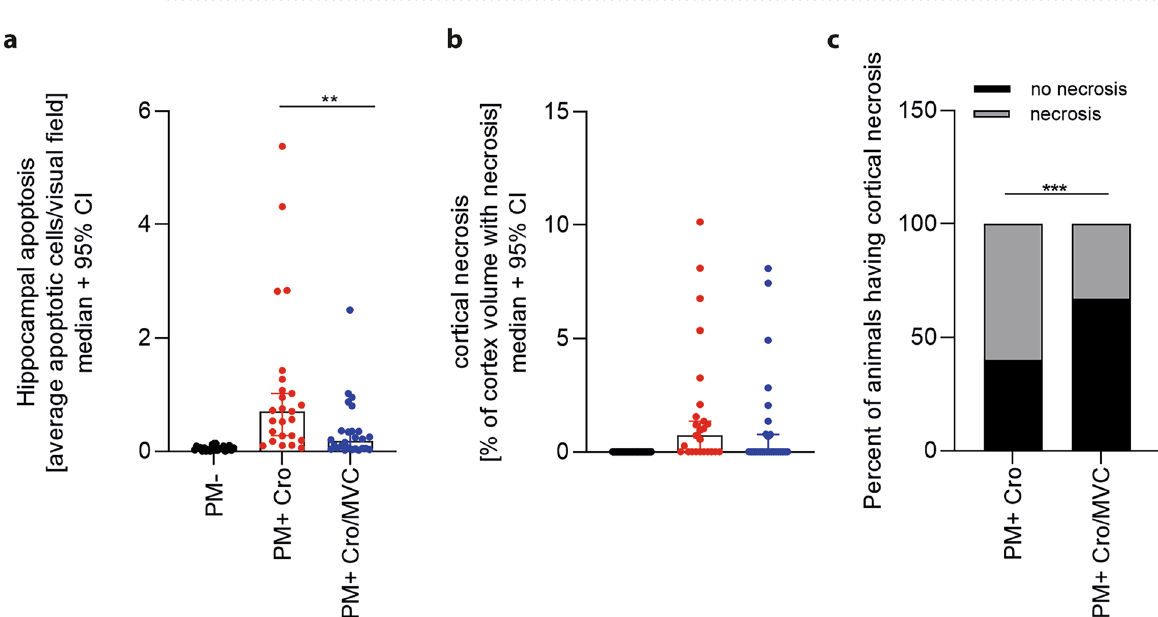
Figure 3. Histological analyses of rat brains during acute PM. ( a ) MVC treatment significantly reduced hippocampal apoptosis in infected animals compared to vehicle treatment, but not cortical necrosis ( b ) (PM- n = 24; PM + Cro n = 25; PM + Cro/MVC n = 26. ( c ) MVC reduced the number of infected animals displaying cortical necrosis. Data are presented as mean ± SD if not stated otherwise. p < 0.05, ** p < 0.01, *** p < 0.001, and **** p < 0.0001 (Mann–Whitney